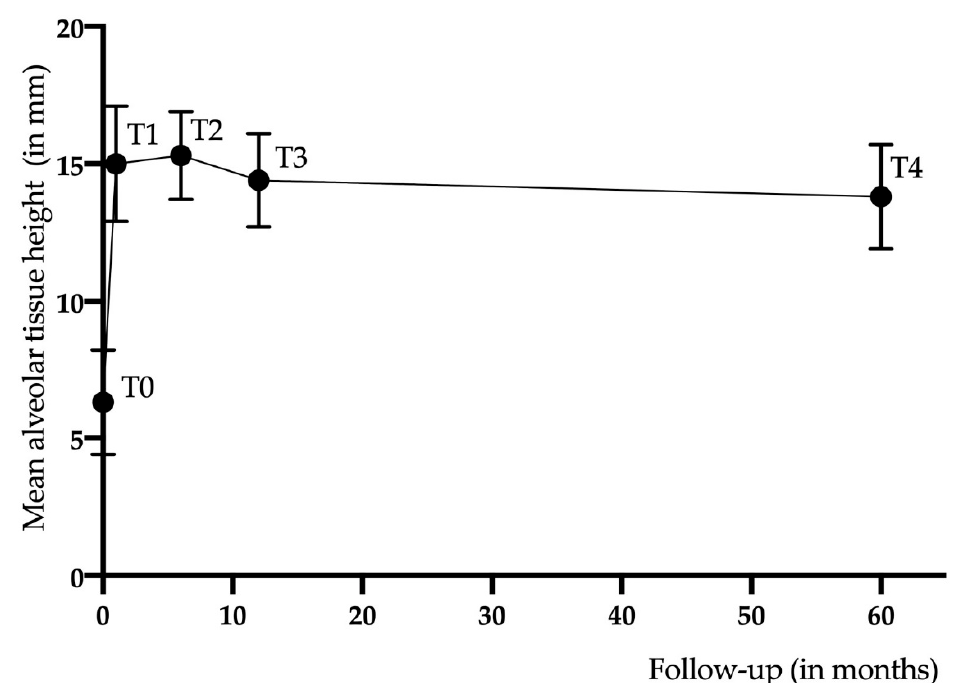
Figure 2. Mean alveolar tissue height (in true mm) over a 5-year period in five patients in whom a maxillary sinus floor elevation procedure was performed with autogenous bone from the maxillary tuberosity and Straumann ® bone ceramic (60:40) with 6 months healing period. T0: (native bone height) preoperative alveolar bone height (SD ± 1.9); T1: directly after a maxillary sinus floor